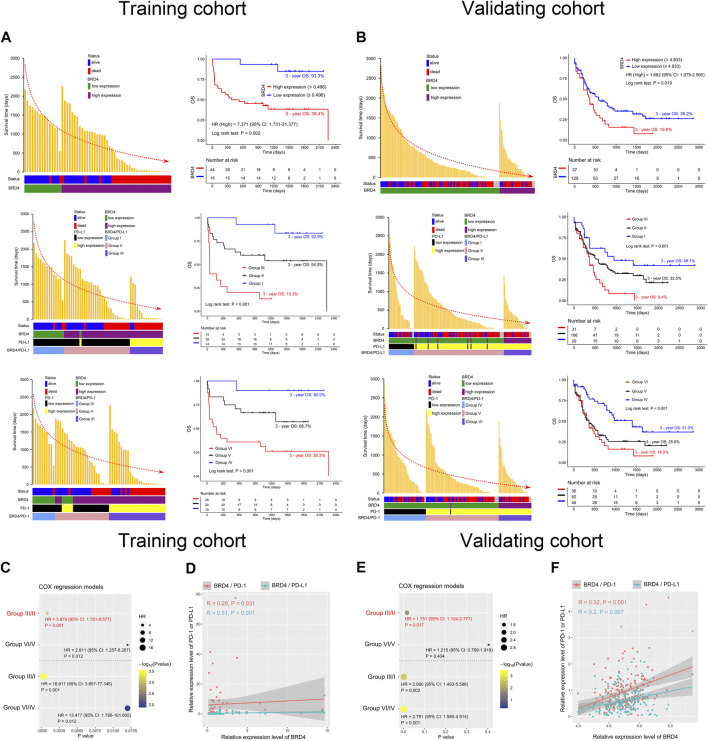
Co-expression of BRD4 and PD-1 or PD-L1 predicts poor overall survival (OS) in AML patients. (A,B) Survival time distribution (left panel) and Kaplan-Meier curves (right panel) plotted according to BRD4 expression status (upper panel), and the BRD4/PD-L1 (middle panel) and BRD4/PD-1 (lower panel) combinations in the training (A) and validating (B) cohorts. The red dotted line represents the change of survival time. (C,E) COX proportional hazards models constructed based on BRD4/PD-L1 or BRD4/PD-1 expression in the training (C) and validating (E) cohorts. (D,F) Analysis of the correlation between BRD4 and PD-L1/PD-1 using Spearman’s method for the training (D) and validating (F) cohorts. Group I: BRD4lowPD-L1low; Group II: BRD4highPD-L1low or BRD4lowPD-L1high; Group III: BRD4highPD-L1high; Group IV: BRD4lowPD-1low; Group V: BRD4highPD-1low or BRD4lowPD-1high; Group VI: BRD4highPD-1high; HR: hazard ratio.